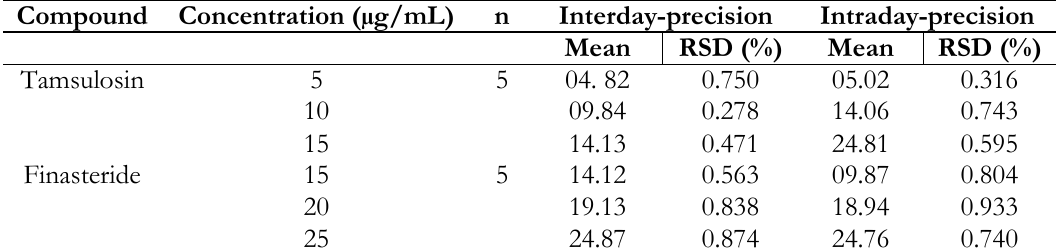
Table IV. Statistical Evaluation of Precision of developed method